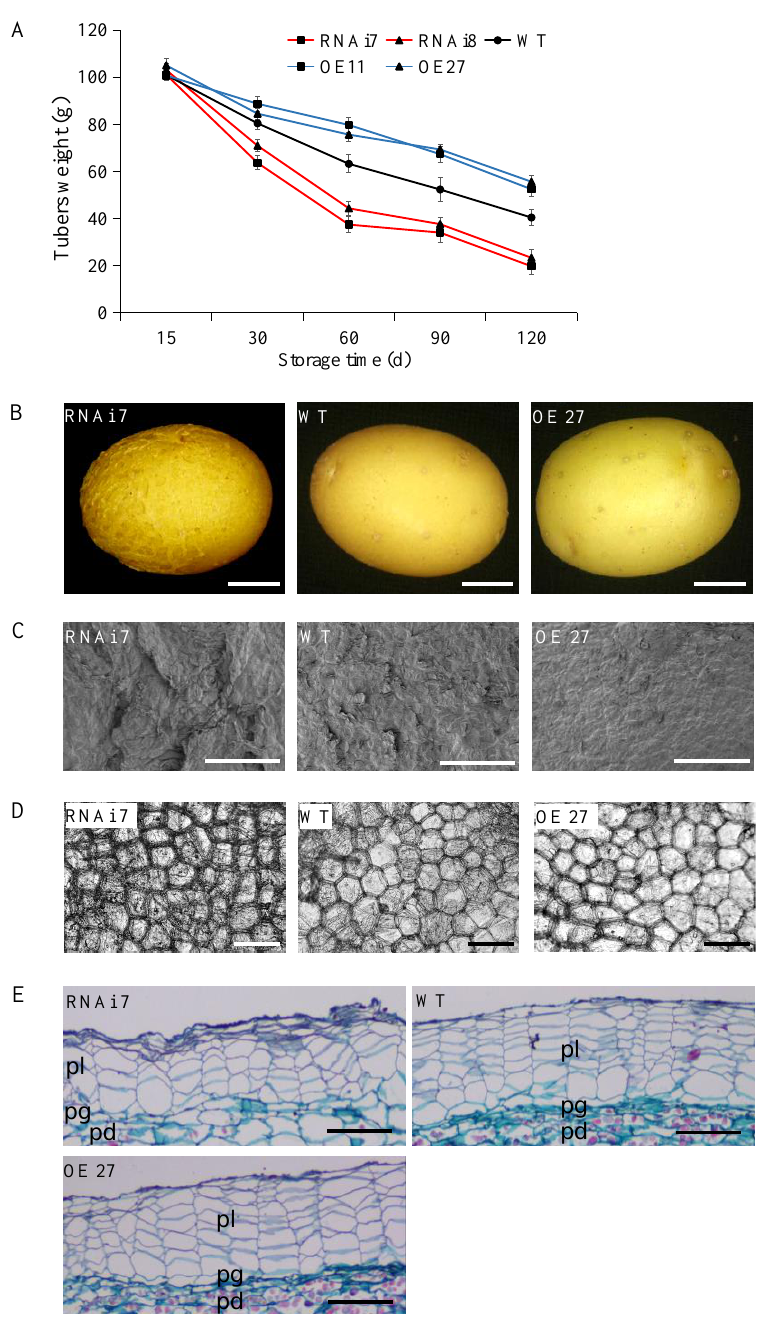
Figure 3. Morphological alterations in transgenic tubers. ( A ) Tuber weight of transgenic lines and wild-type (WT). ( B ) Tuber phenotype of RNAi line 7, OE line 27 and wild-type (WT) plants. Scale bar = 5 mm. ( C ) Scanning electron microscopy (SEM) micrograph of the skin surface from a wild-type and transgenic tuber. Scale bar = 500 μm. ( D ) Micrograph of different tuber skins. Scale bar = 100 μm. ( E ) Microscopy of cross sections of transgenic tuber and wild-type (WT). pl, phellem; pg, phellogen; pd, phelloderm. Scale bar = 100 μm.